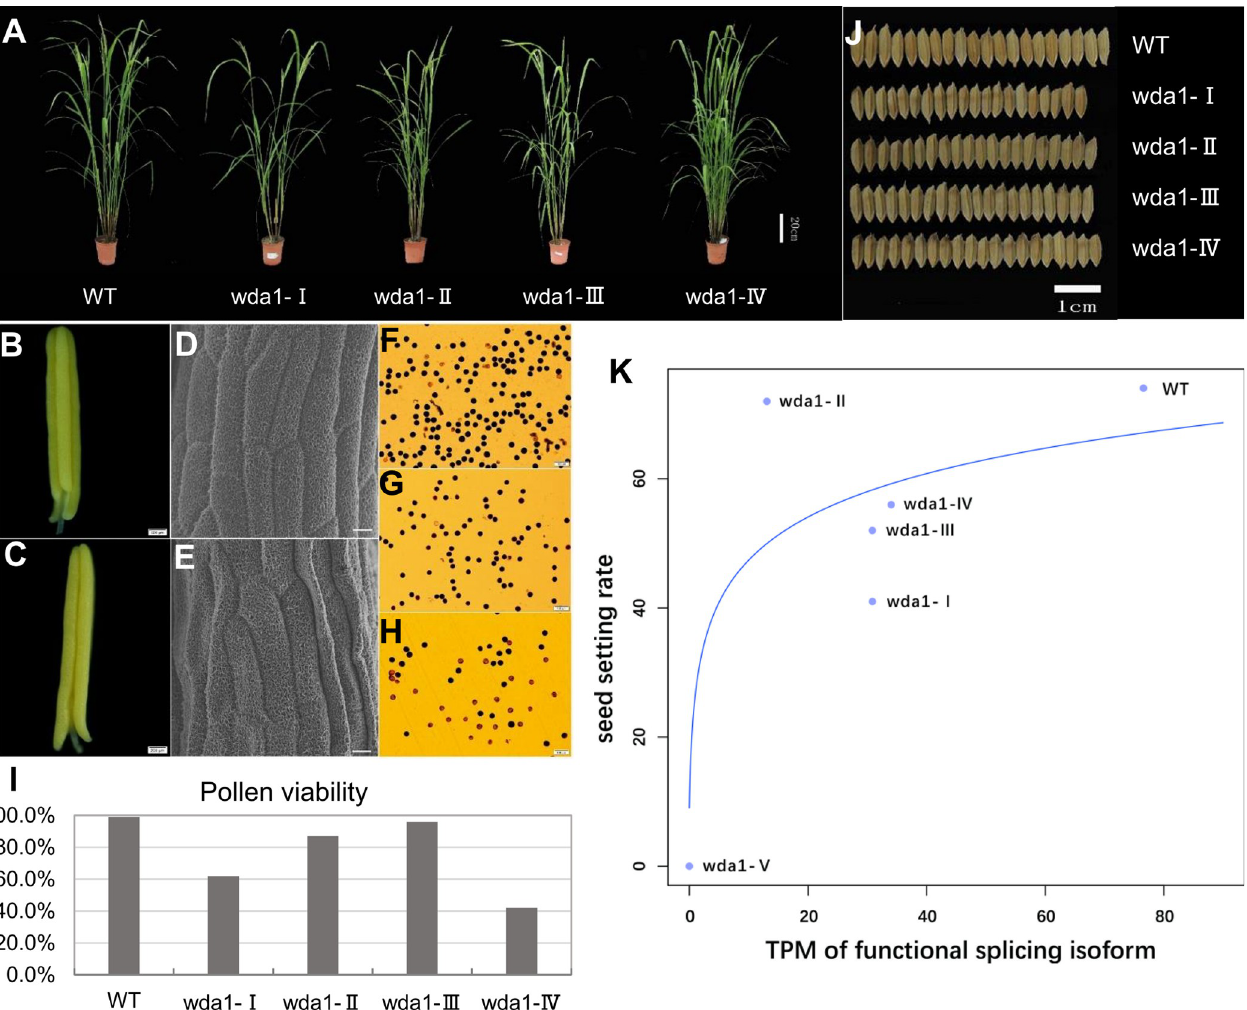
Fig 4. Phenotypic comparison between wild-type and wda1 mutant plants. (A) Phenotypic comparison of wild-type and mutant plants at heading stage. Scale bars, 20cm. (B) Morphology of anthers observed by optical microscope in WT. Scale bars, 200 μ m. (C) Morphology of anthers observed by optical microscope in mutant of wda1-I . Mutants of wda1- II , III and IV have similar anthers to wda1-I . Scale bars, 200 μ m. (D) SEM analysis of the exine characteristics of mature anthers of WT. Scale bars, 10 μ m. (E) SEM analysis of the exine characteristics of mature anthers of mutant of wda1-I . Mutants of wda1- II , III and IV have similar exine characteristics to wda1-I . Scale bars, 10 μ m. (F) I 2 -KI staining of pollen grains for WT. (G-H) I 2 -KI staining of pollen grains for mutant of wda1-I . Mutants of wda1- II , III and IV have similar staining pattern to wda1-I . Scale bars, 100 μ m. (I) Pollen viability of mutants of wda1-I , II , III and IV observed by I 2 -KI staining. Pollen grains that were round and stained black by I 2 -KI were considered viable, and those stained yellow or light red were judged as sterile. The percentage of pollen viability was calculated as viable pollen relative to total pollen counted (J) Seed morphology of wild- type and mutants. Scale bars, 1cm. (K) The relation between the expression level of the splicing isoform (in TPM) that produces functional protein and fertility. The TPM of Os- wda1 -A in WT and the TPM of Os- wda1 -B in wda1-I , II , III and IV were used. For wda1 - V we assumed it could be set at the origin. The blue line is the fit of y = f(log(x+0.1)), r 2 = 76%, P = 0.02393. Each genotype has three